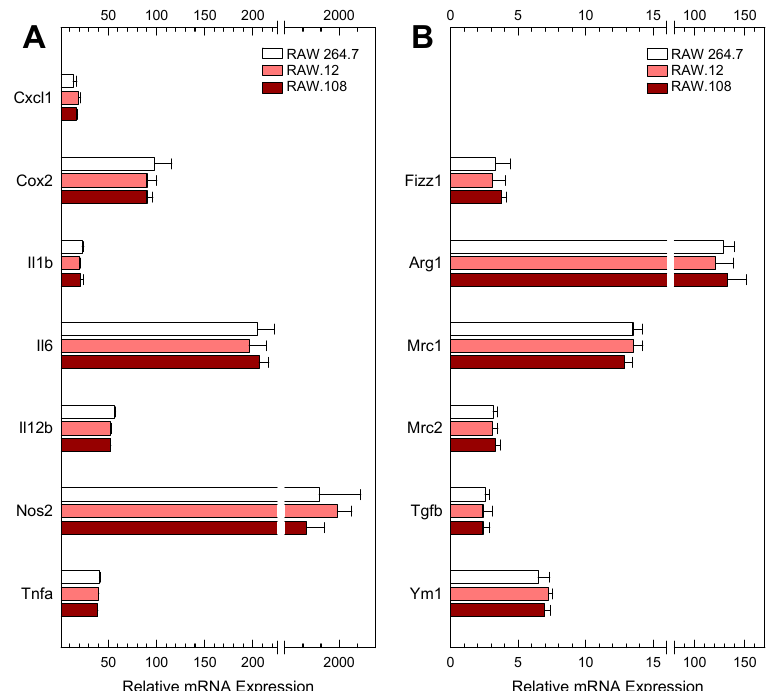
Figure 5. Macrophage polarization through the classic pro-inflammatory (M1) and alternative (M2) pathways: RAW 264.7 cells (open bars) and their plasmalogen-defective variants RAW.12 (light red bars) and RAW.108 (dark red bars) were treated for 8 h with LPS (250 ng/mL) plus interferon- γ (500 U/mL) ( A ) or with interleukin-4 (20 ng/mL) plus interleukin-13 (20 ng/mL) ( B ) to generate classically (M1) or alternatively (M2) polarized macrophages, respectively. Afterward, the expression of the indicated markers was studied by qPCR. Data are relative to basal expression levels and normalized to cyclophilin A. A representative experiment is shown, and the data are expressed as means ± S.E.M. of three individual replicates.